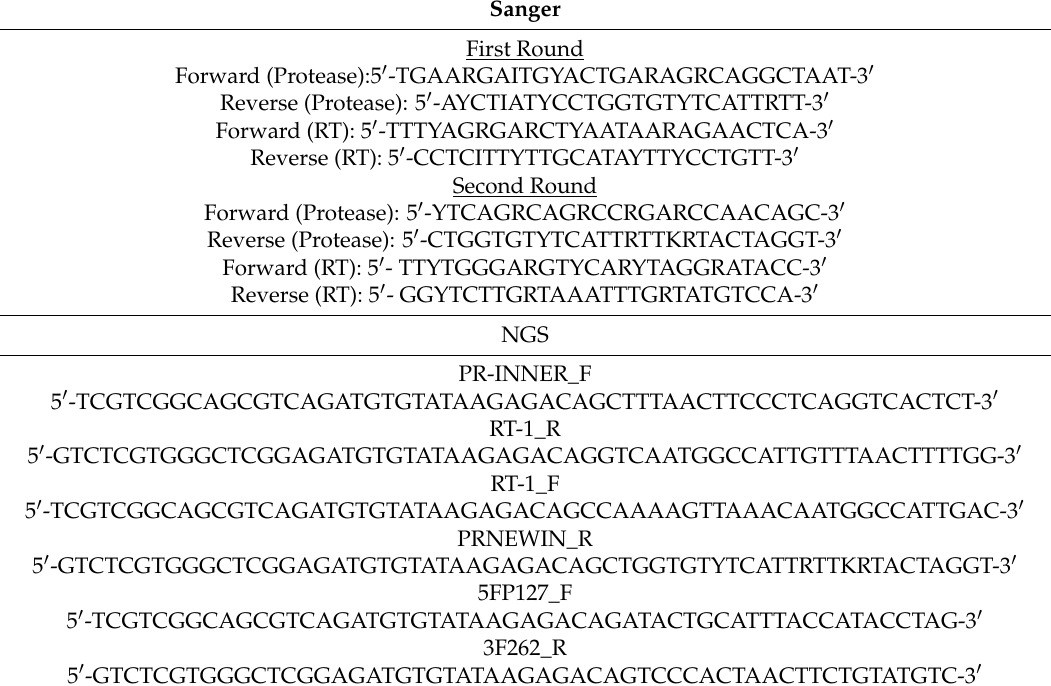
Table 1. Primers used for RT-PCR and PCR procedures.